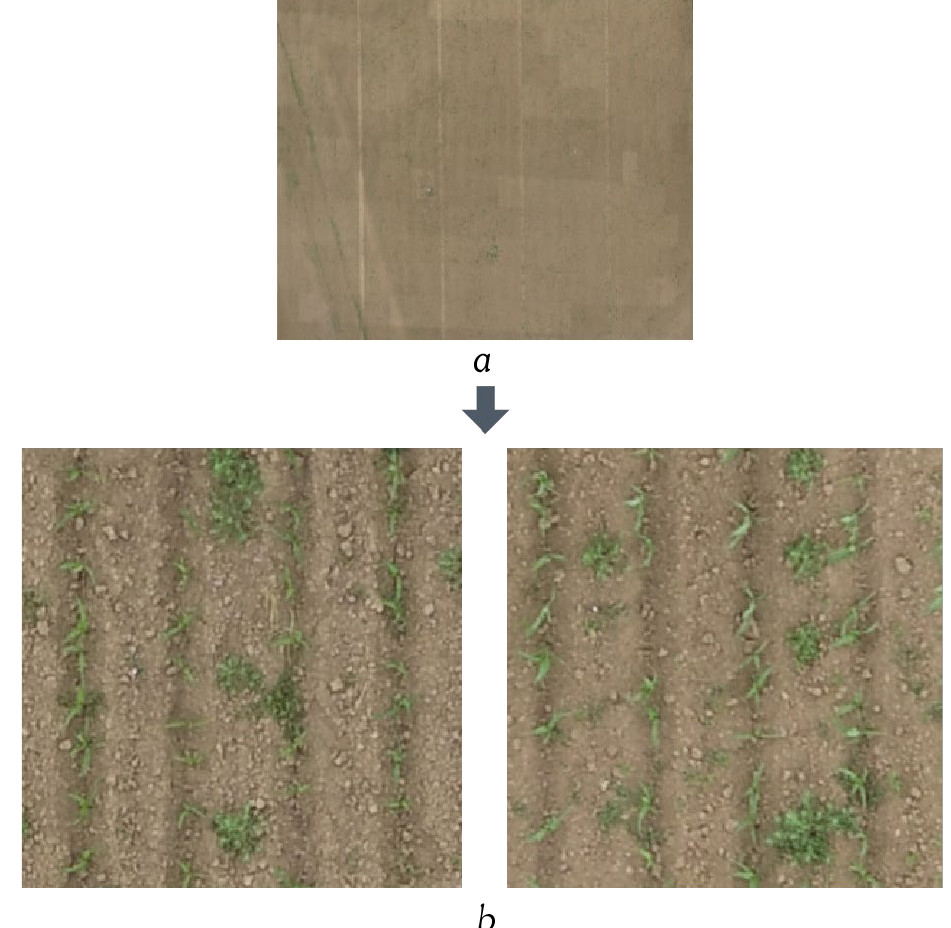
Figure 3. Steps of image processing: ( a ) remove the edge, and ( b ) image cropping.